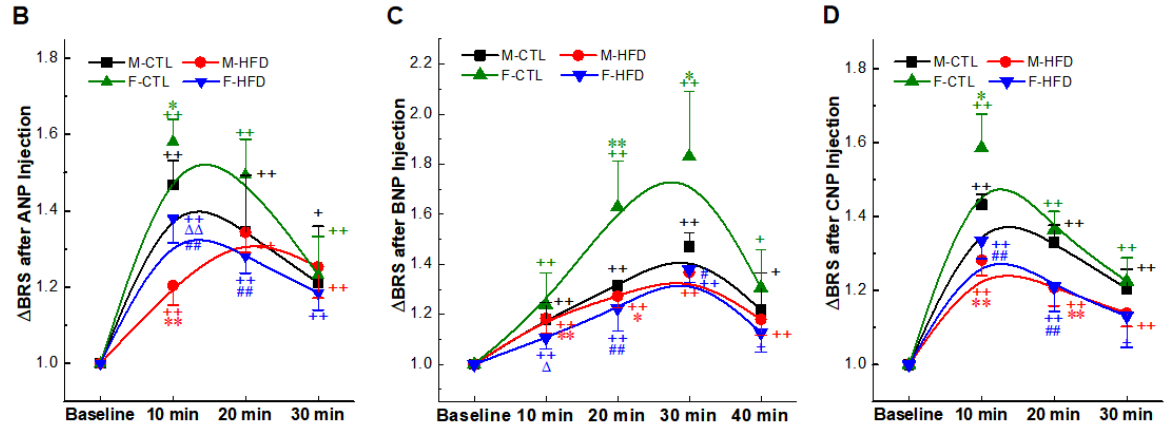
Figure 4. The baroreceptor sensitivity (BRS) improvement effects of natriuretic peptides (NPs) administration in high-fructose-drinking-induced hypertension (HFD) rats. NPs 1 mg/mL, 25 µ g/kg was administrated intravenously (i.v.). ( A ) The mean arterial pressure (MAP) and heart rate (HR) were recorded in the presence of ANP before and after intravenous injection of 3 µ g/kg phenylephrine (PE). The BRS was presented as ∆ HR/ ∆ MAP (bpm/mmHg). ( B – D ) Quantitative analysis results of BRS. Averaged data was presented as mean ± SD. * p < 0.05, ** p < 0.01 vs. M-CTL with the same treatment, # p < 0.05, ## p < 0.01 vs. F-CTL with the same treatment, ∆ p < 0.05, ∆∆ p < 0.01 vs. M-HFD with the same treatment, + p < 0.05, ++ p < 0.01 vs. baseline, n = 5 rats for each group.